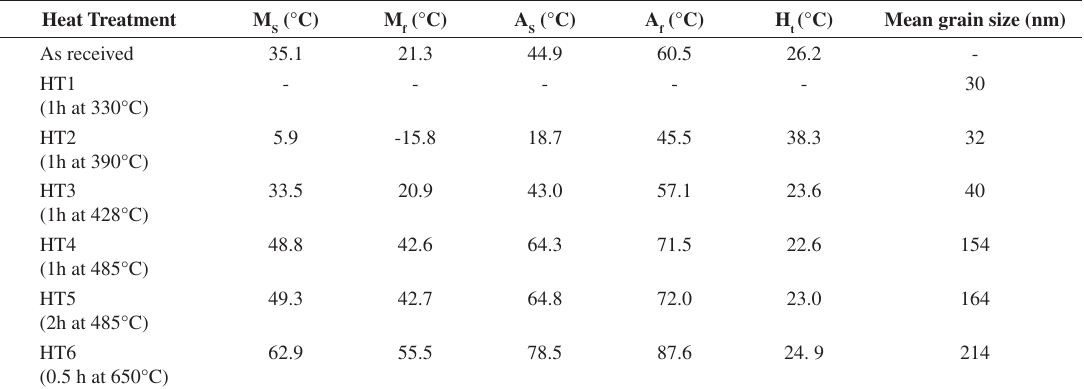
Figure 1. TEM images of Ti-Ni-Cu: a) After cold work without HT, b) After HT1 (330°C 1h), c) After HT2 (390°C 1h), d) after HT3 (428°C 1h), e) After HT4 (485°C 1h), f) after HT5 (485°C 2h), g) after HT6 (650°C 0.5h) and h) Magnification from Figure 1g). Table 2. Transformation temperatures at 10% and 90% of transformation, hysteresis and mean grain size for different heat